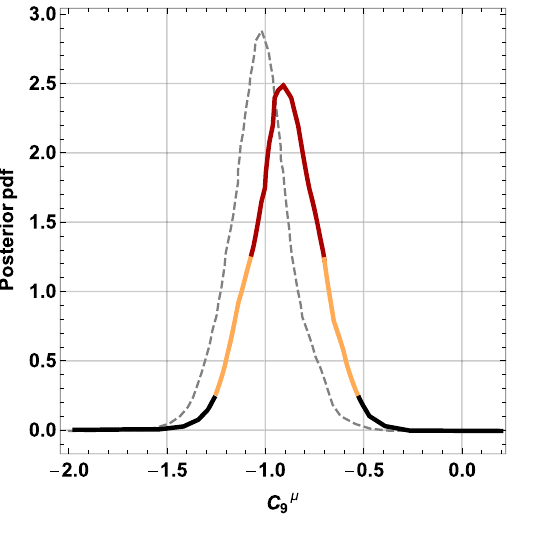
dashedlineshows theposteriorpdfcorresponding tothedatapre-LHCb μ Run 2. b Same as a for the scan parametrized by C (first row of Table 2). 9 row of Table